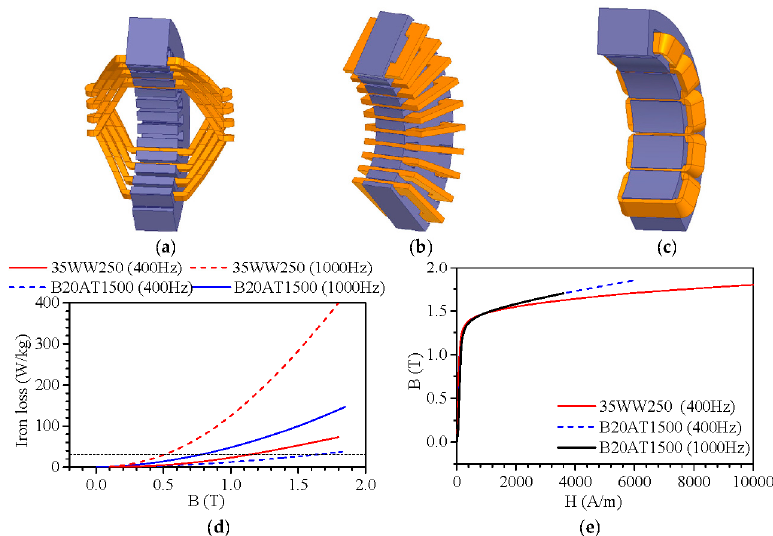
Figure 1. Configurations of, ( a ) double-layer lap windings; ( b ) toroidal windings; ( c ) concentrated